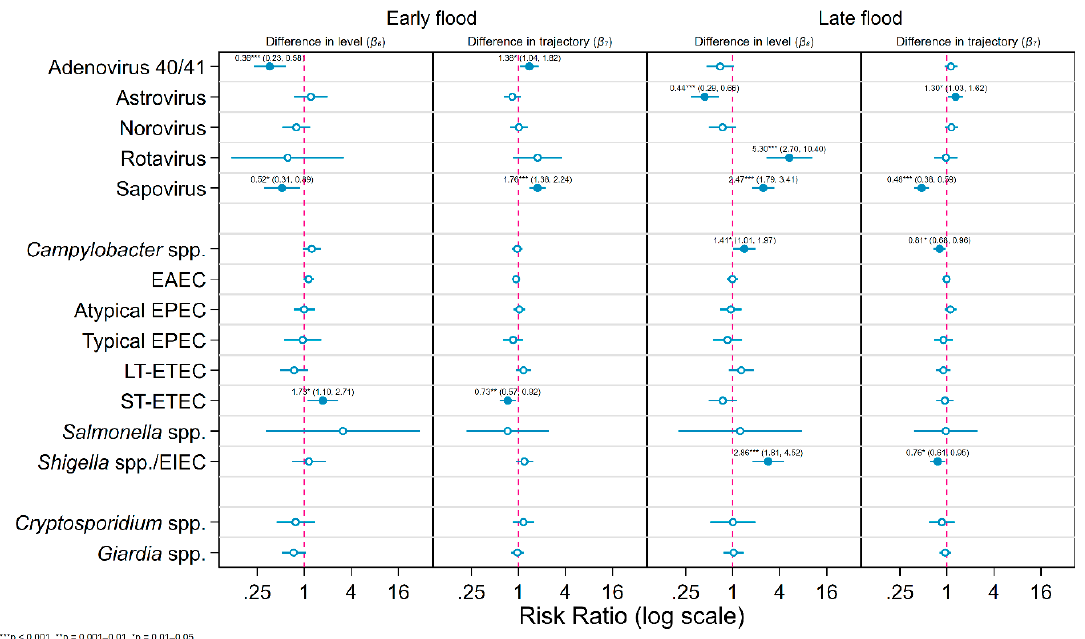
Figure 3. Risk ratios for detection of specific enteric pathogen species in stool samples collected from infants aged 0–2 years during each of the two flood periods relative to the pre-/post-flood period and to the control sites estimated for generalized linear models that adjusted for seasonality, site, age, sample type, and diagnostic method.